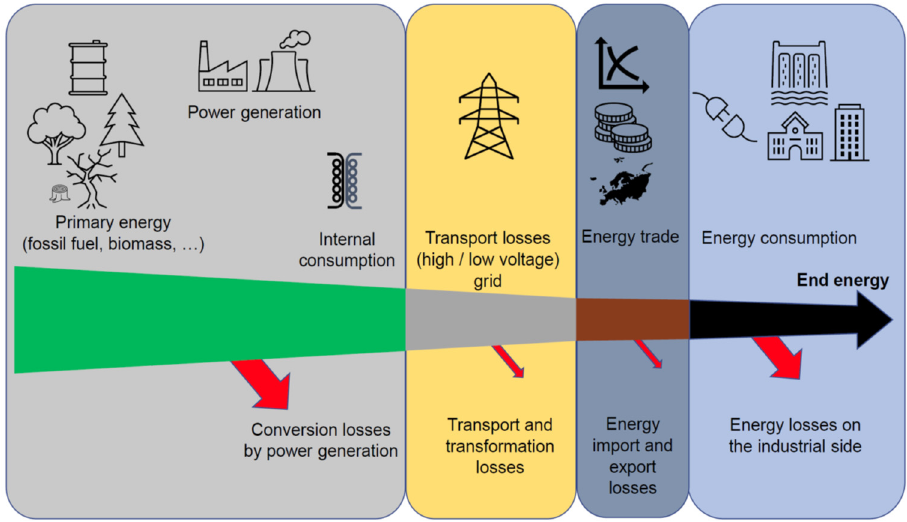
Figure 1. Carbon intensity of electricity from primary source production to consumption, based on work in Reference [52].